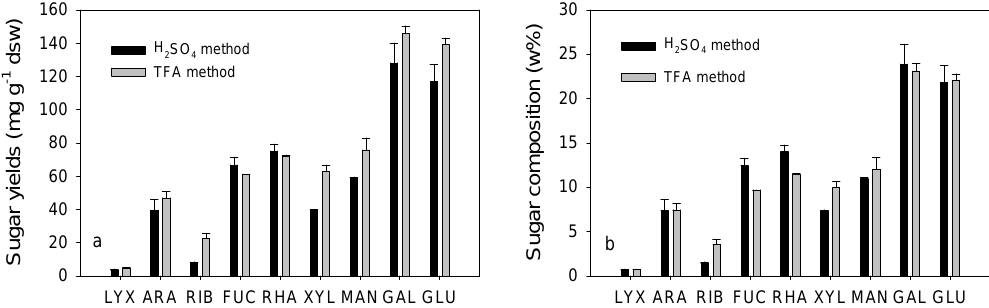
Fig. 3. Monosaccharide yields (mgg − 1 dry sediment weight) (a) and neutral sugar compositions (wt %) (b) from surface sediments using different hydrolytic procedures. The error bars represent the standard deviation ( n = 5). Table 3. Organic geochemical data for surface sediments, and the fraction of terrigenous organic matter contribution to sediment TOC in the upper reach of the Pearl River Estuary, Lingdingyang Bay and the SCS shelf.